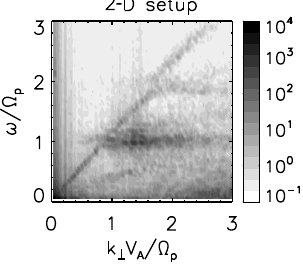
Figure 4. Wavenumber–frequency spectrum for magnetic field fluc- tuations in a 2-D plasma simulation at a time of 600 ion gyro- periods.